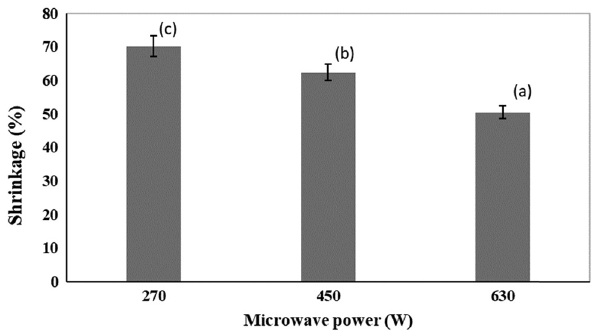
Figure 11: Shrinkage of dried pomegranate arils in MW dryer. The bars represent mean values and the corresponding standard deviations. Bars with the same letter are not signi fi cantly di ff erent according to ANOVA and Tukey test ( p < 0.05 )